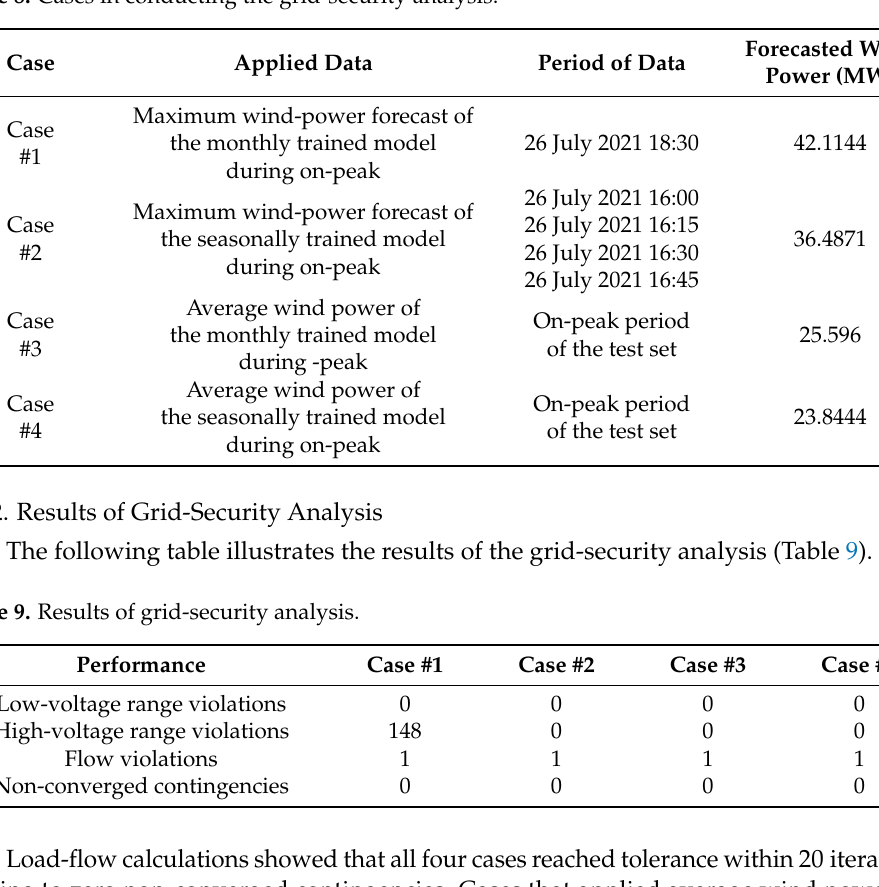
Table 8. Cases in conducting the grid-security analysis.